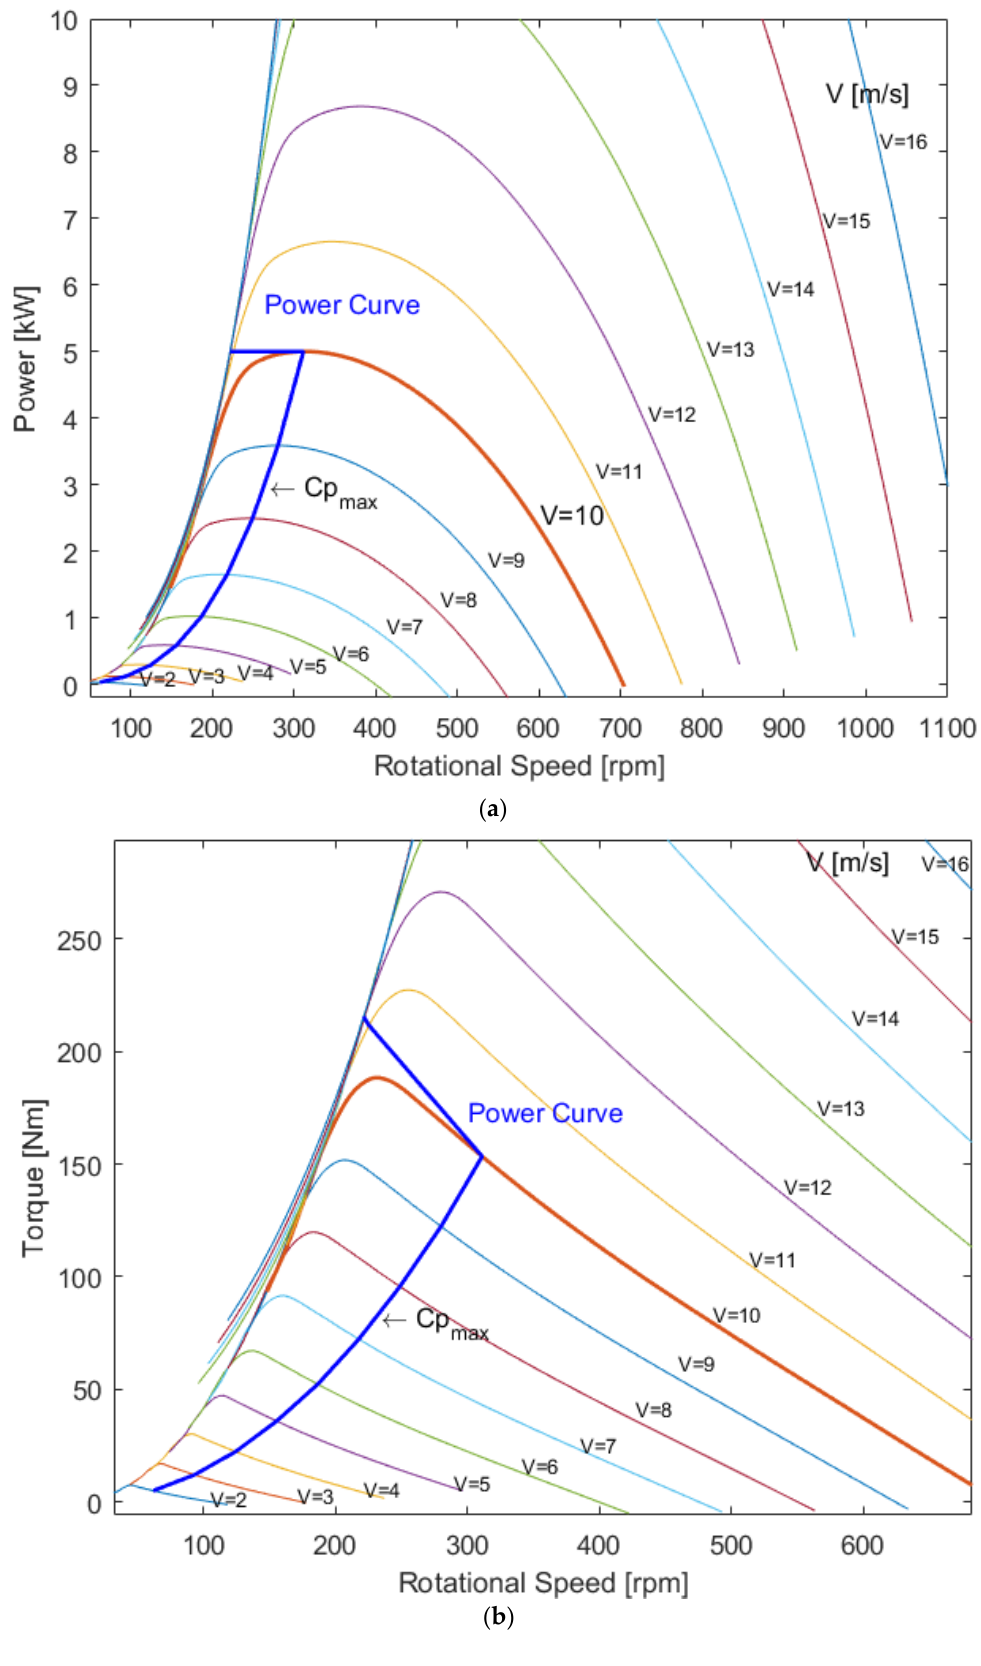
Figure 7. ( a ) Power vs. rotor speed including maximum power graphs for variable speed operation of the designed blade and ( b ) torque vs. rotor speed, including maximum power graphs for variable speed operation of the designed blade.